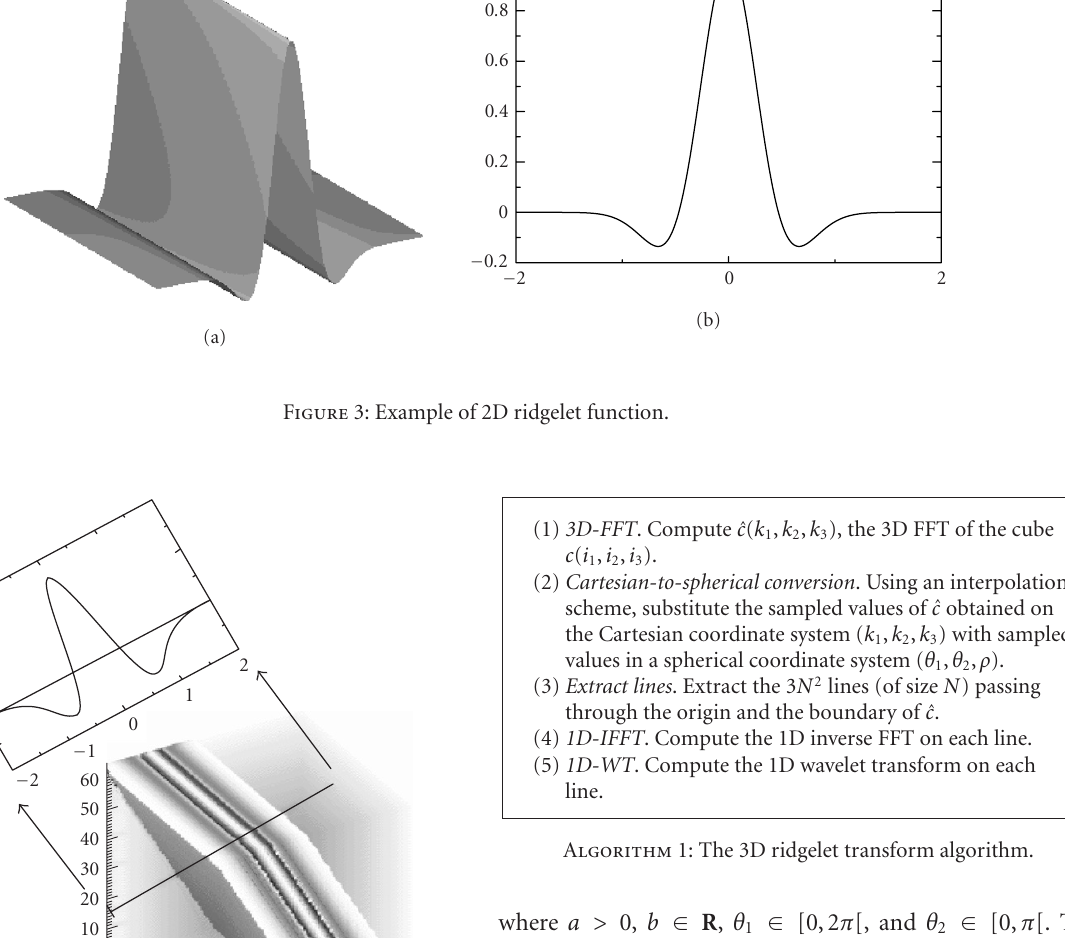
Algorithm 1: The 3D ridgelet transform